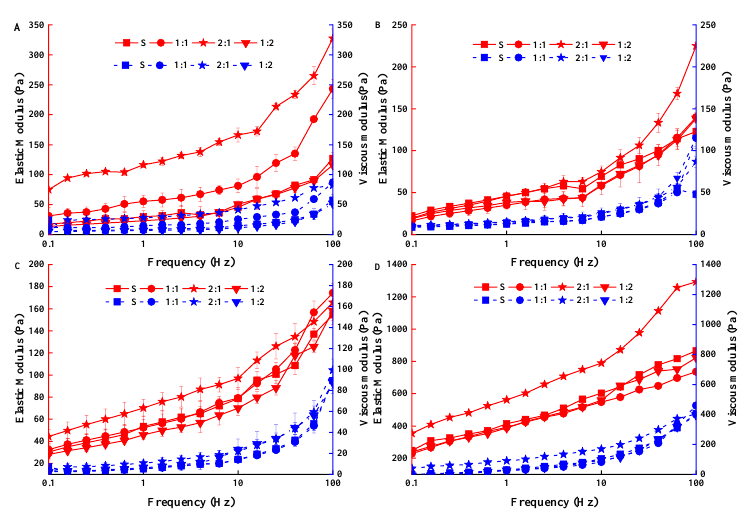
Figure 4. The elastic modulus G’ and the viscous modulus G″ of yogurt were added with different proportions of MC5 during storage. ( A – D ) G ′ and G″ of the four groups of yogurt on the 1st, 7th, 14th, and 21st days of storage, respectively. Error bars represent the standard errors (se) of the model-fitted mean value ( n = 3).